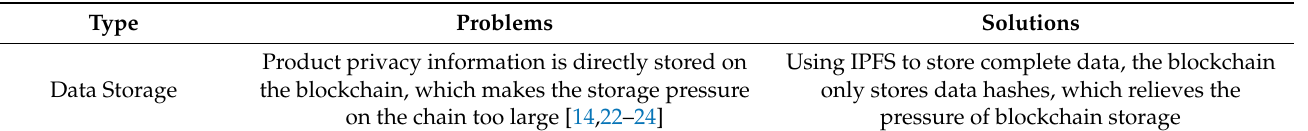
Table 4. Problems facing current product certification schemes and countermeasures in this